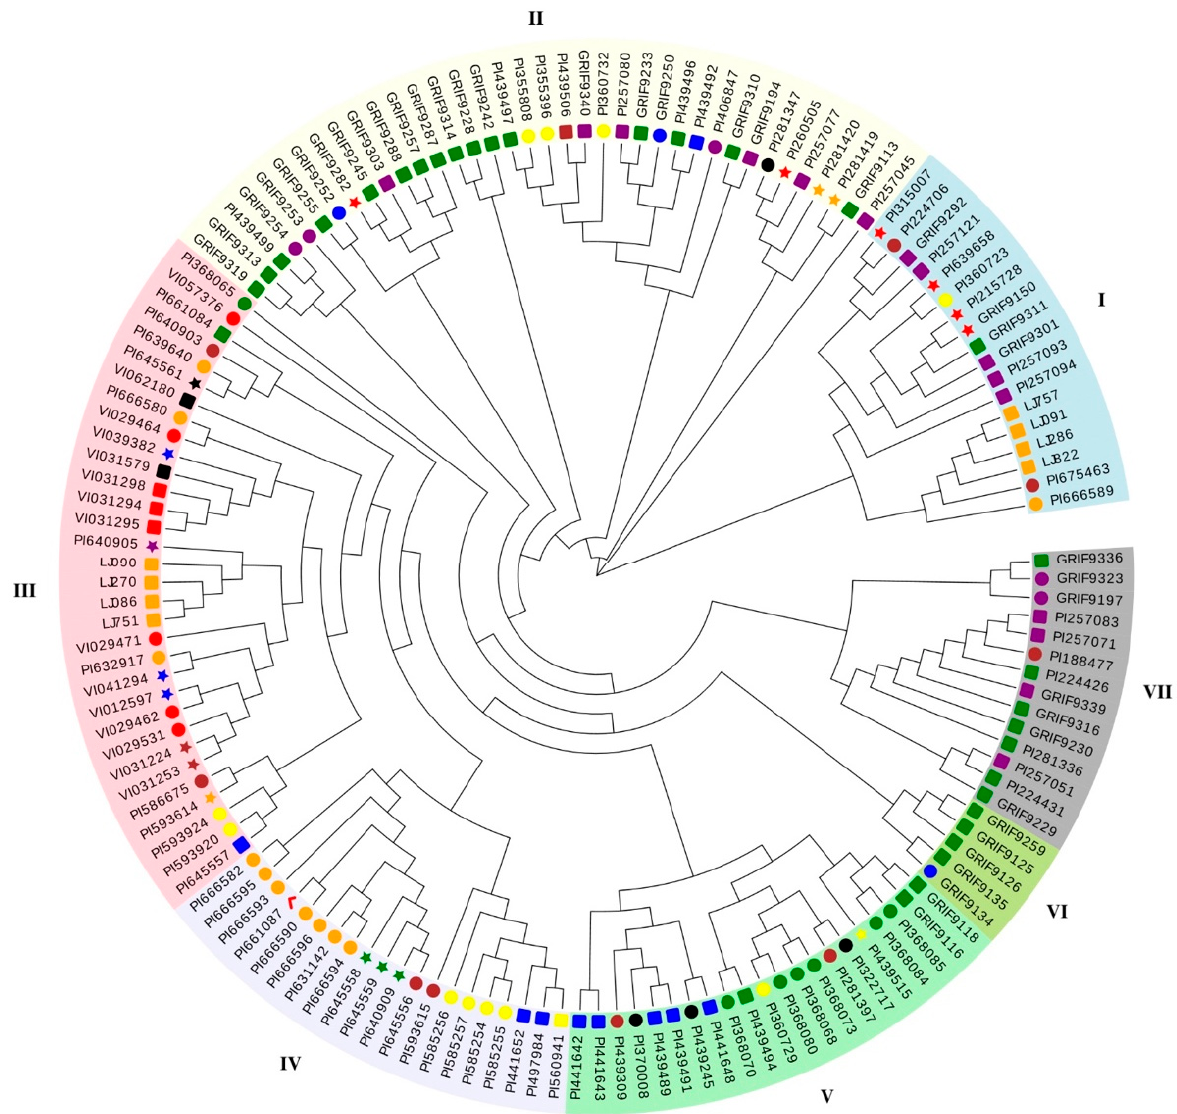
Figure 3. Dendrogram was constructed based on the genotypes from 33 SSR markers using neighbor-joining methods, and the icons indicated the information of material source, which was shown in Figure 2B.